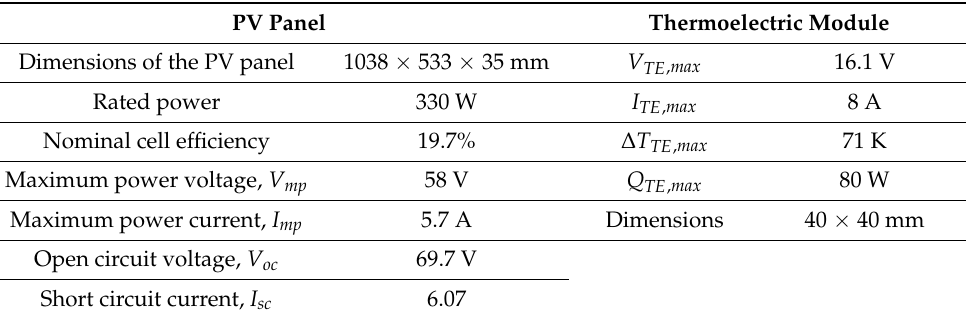
Table 3. Characteristics of the PV panel and the thermoelectric module. PV Panel Thermoelectric Module Dimensions of the PV panel 1038 × 533 × 35 mm V TE , max 16.1 V Rated power 330 W I TE , max 8 A Nominal cell efficiency 19.7% ∆ T TE , max 71 K Maximum power voltage, V mp 58 V Q TE , max 80 W Maximum power current, I mp 5.7 A Dimensions 40 × 40 mm Open circuit voltage, V oc 69.7 V Short circuit current, I sc